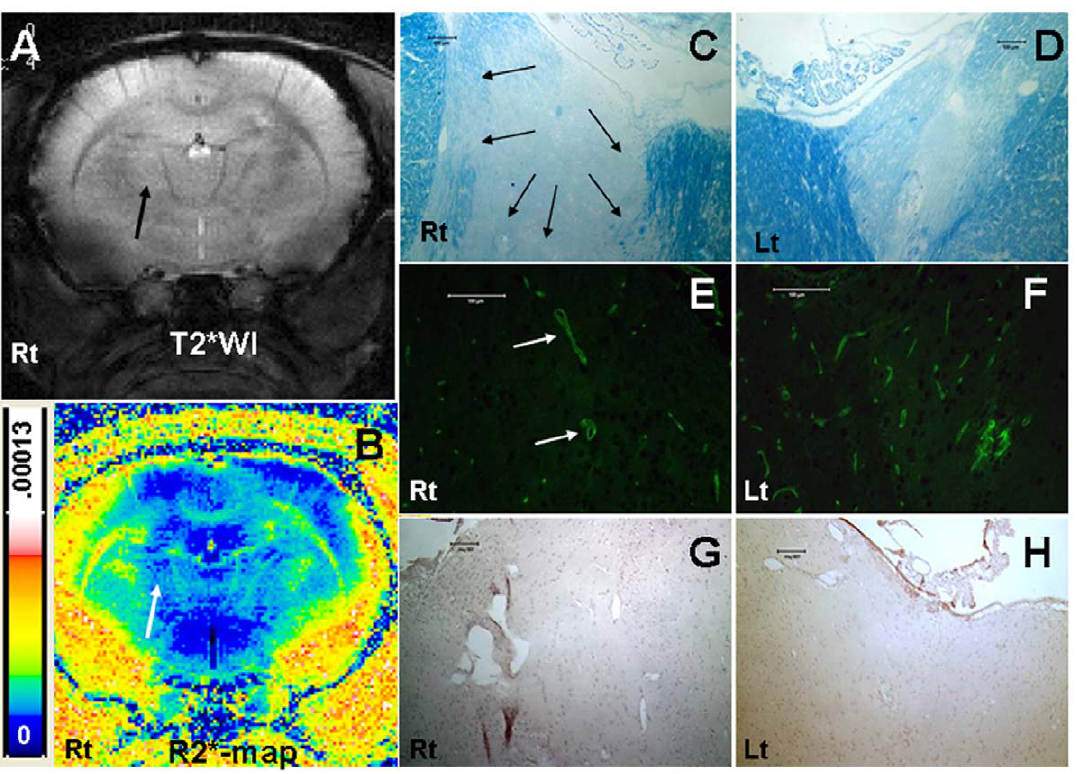
Figure 6. MRI and histology in radiation injury. Representative magnetic resonance imaging and corresponding histochemical analysis of radiation injured (8 weeks after 50Gy focal irradiation) animal that received labeled CTL. (A) T2*-weighted image showed no definite low signal intensity area at the site of radiation injury (arrow) compared to contralateral hemisphere. (B) Corresponding R2* map also showed no high signal intensity area. Luxol fast blue staining revealed extensive loss of myelination at the site of radiation injury (C) compared to that at the corresponding site of contralateral normal hemisphere (D). FITC-tagged tomato lectin staining showed loss of normal blood vessels morphology with evidence of dilatation (arrows) at the corresponding site of radiation injury (demyelinated area) (E), in contrast to the vessel distribution seen in the corresponding site of the contralateral normal hemisphere (F). DAB enhanced Prussian blue staining showed no Prussian blue positive cells at the corresponding radiation injured or contralateral normal hemispheres (G and H). Luxol fast blue, lectin and Prussian blue stained tissues sections were obtained from consecutive slices.